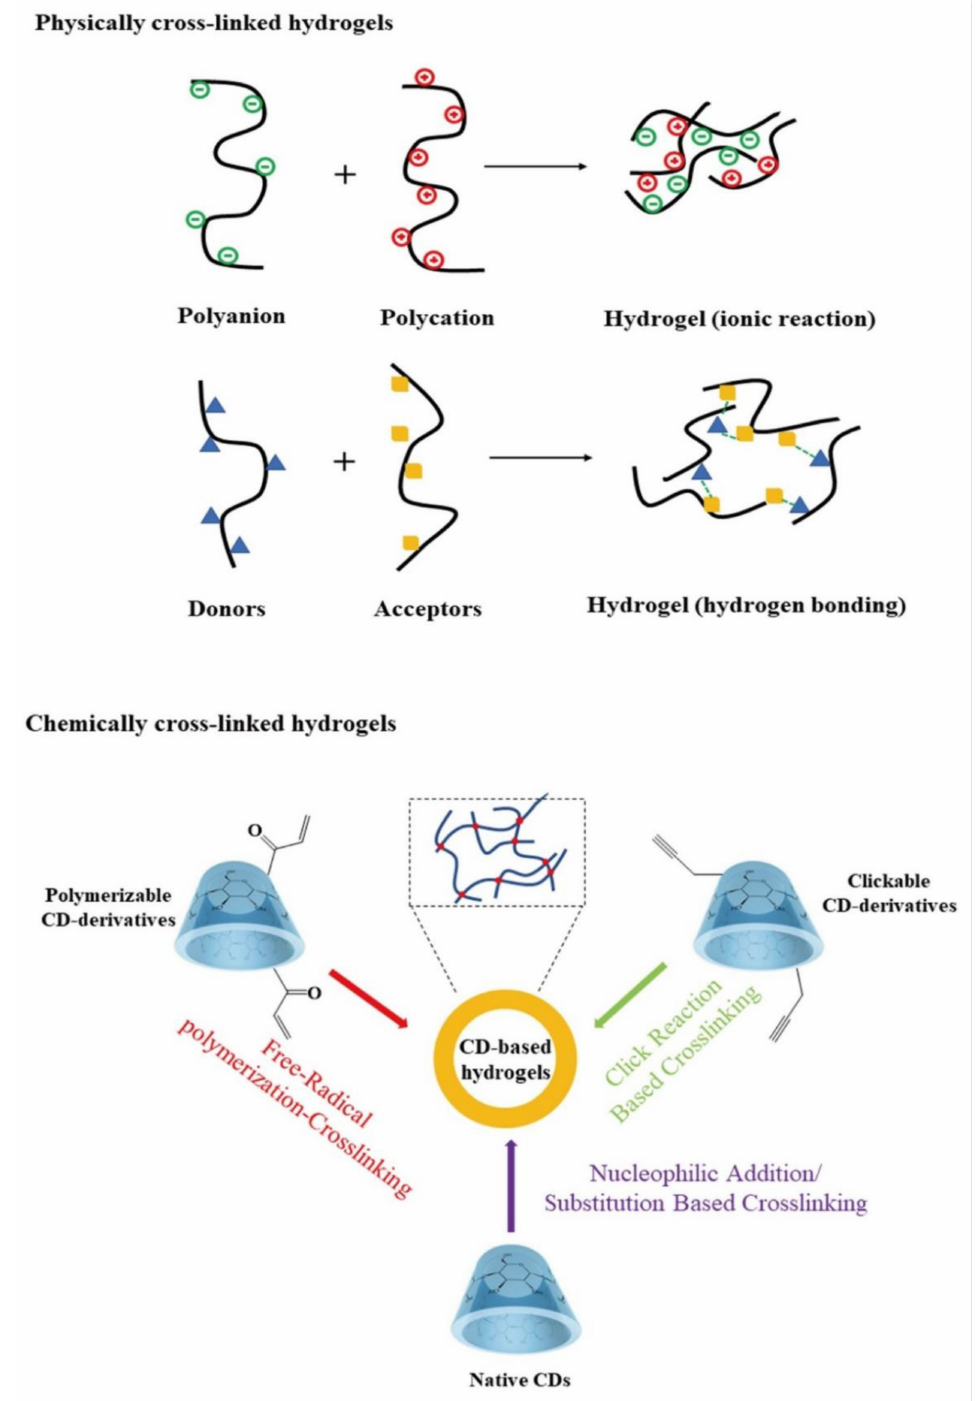
Figure 1. Schematic representation of common methodologies for preparation of CD-containing